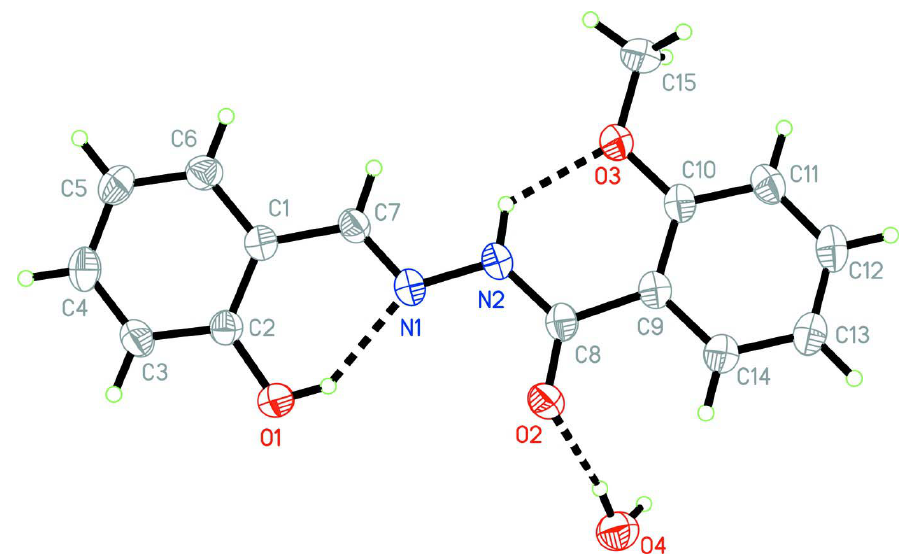
Figure 1 The molecular structure of the title compound, showing 30% probability displacement ellipsoids and the atom-numbering